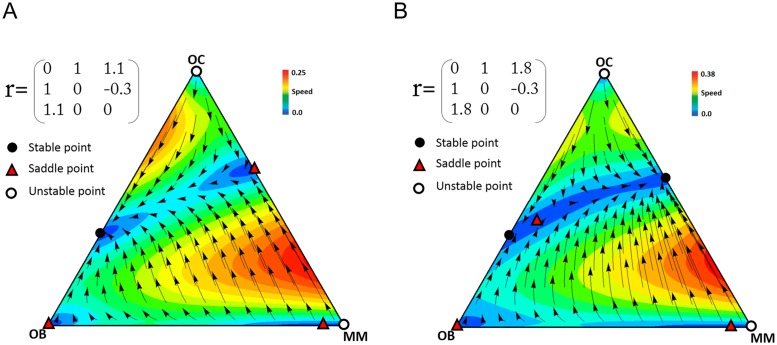
Different types of dynamics for scenario 1.(A) The game has one polymorphic stable point between OB and OC. In this case, clonal selection leads to the regular OC-OB balance and prevents invasion of MM cells. (B) The game has two polymorphic stable points. In this case, the final state of the game depends on the initial frequencies. The arrows show the direction of the dynamics, and the colors show its speed (the euclidean distance between the frequencies at time t and t+1).